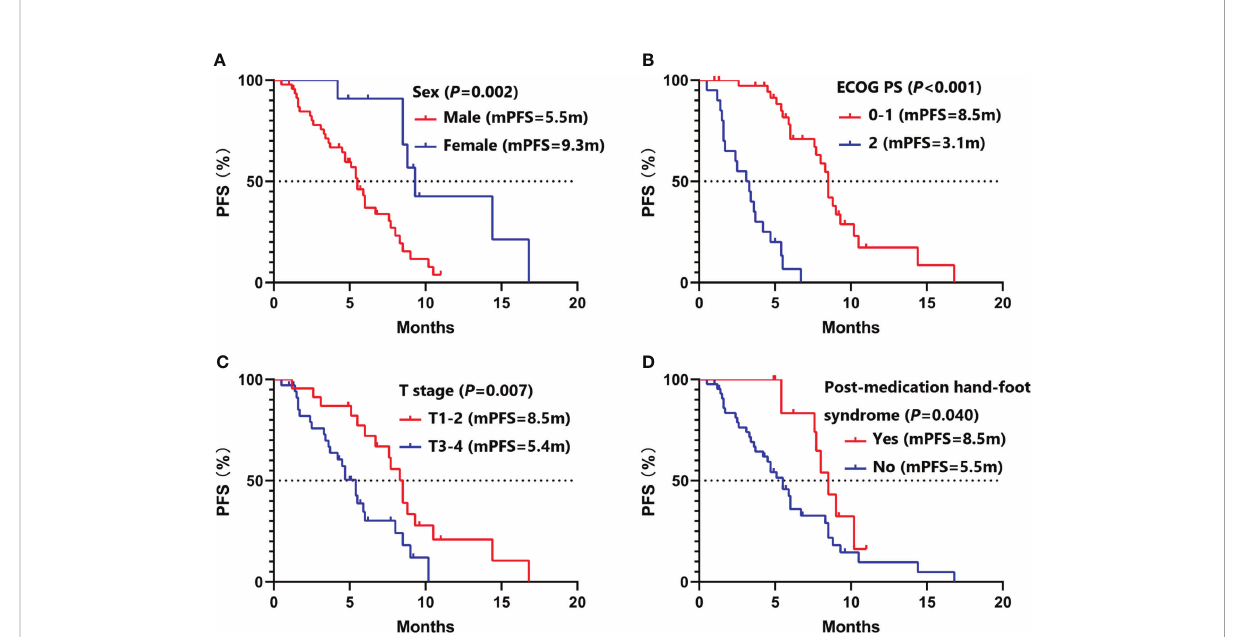
FIGURE 3 Kaplan – Meier curves of PFS in multivariate Cox regression analysis. (A) strati fi ed by sex; (B) strati fi ed by ECOG PS; (C) strati fi ed by T stage; (D) strati fi ed by post-medication hand-foot syndrome. PFS, progression-free survival; ECOG PS, Eastern Cooperative Oncology Group Performance Status.